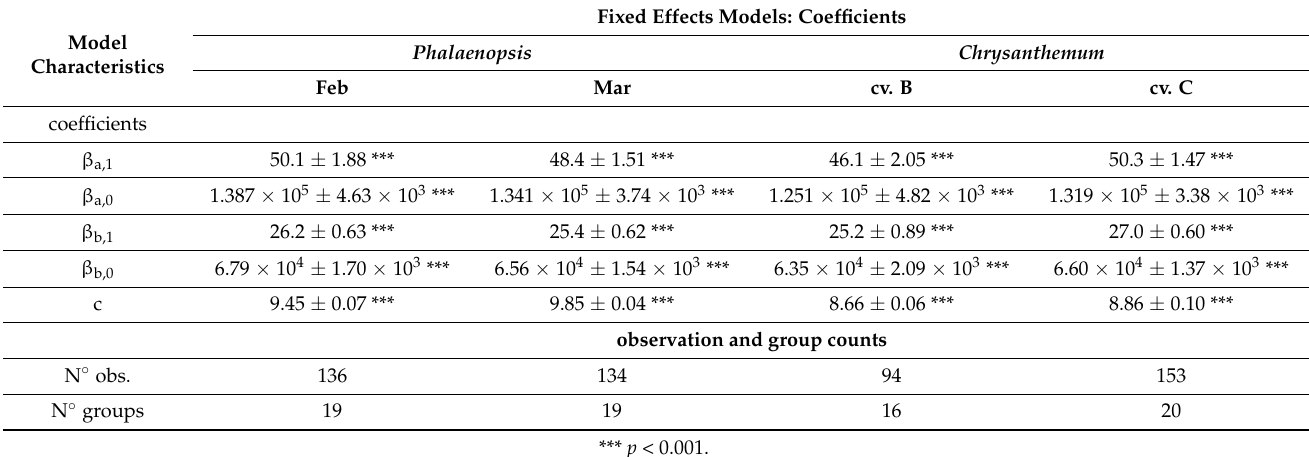
Table 6. Coefficients per set of plant materials for the general fixed-effects model shown as estimate ± SE. Despite March being a replica of the experiment in February, coefficients tend to be different.